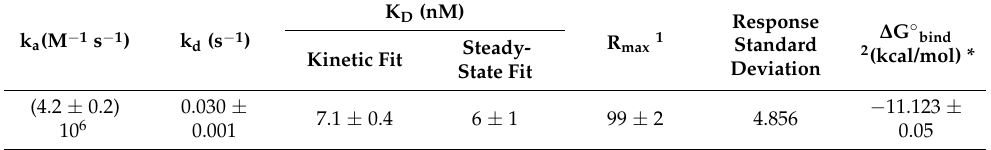
Table 2. Binding kinetics and thermodynamic parameters of G4/muRif1-CTD from SPR